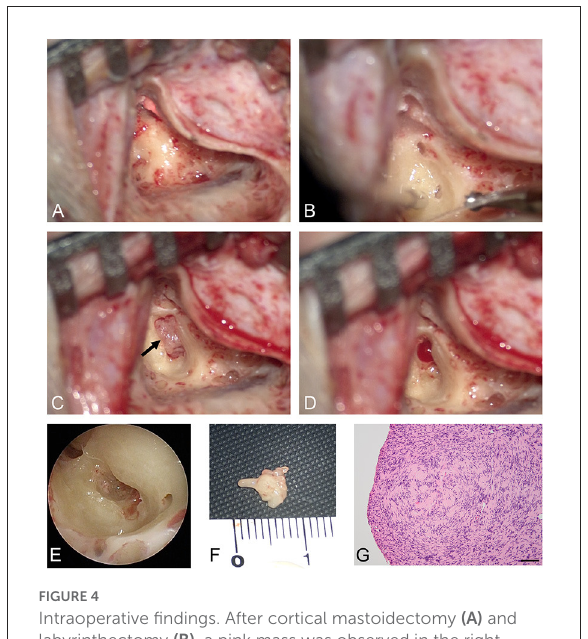
FIGURE4 Intraoperative findings. After cortical mastoidectomy (A) and labyrinthectomy (B) , a pink mass was observed in the right vestibule (arrow) (C) . After tumor resection, the intravestibular region was evaluated both microscopically (D) and endoscopically (E) . An 8-mm mass was excised (F) . (G) High-power microphotograph showed a nuclear palisading pattern. Scale bar = 100 µ